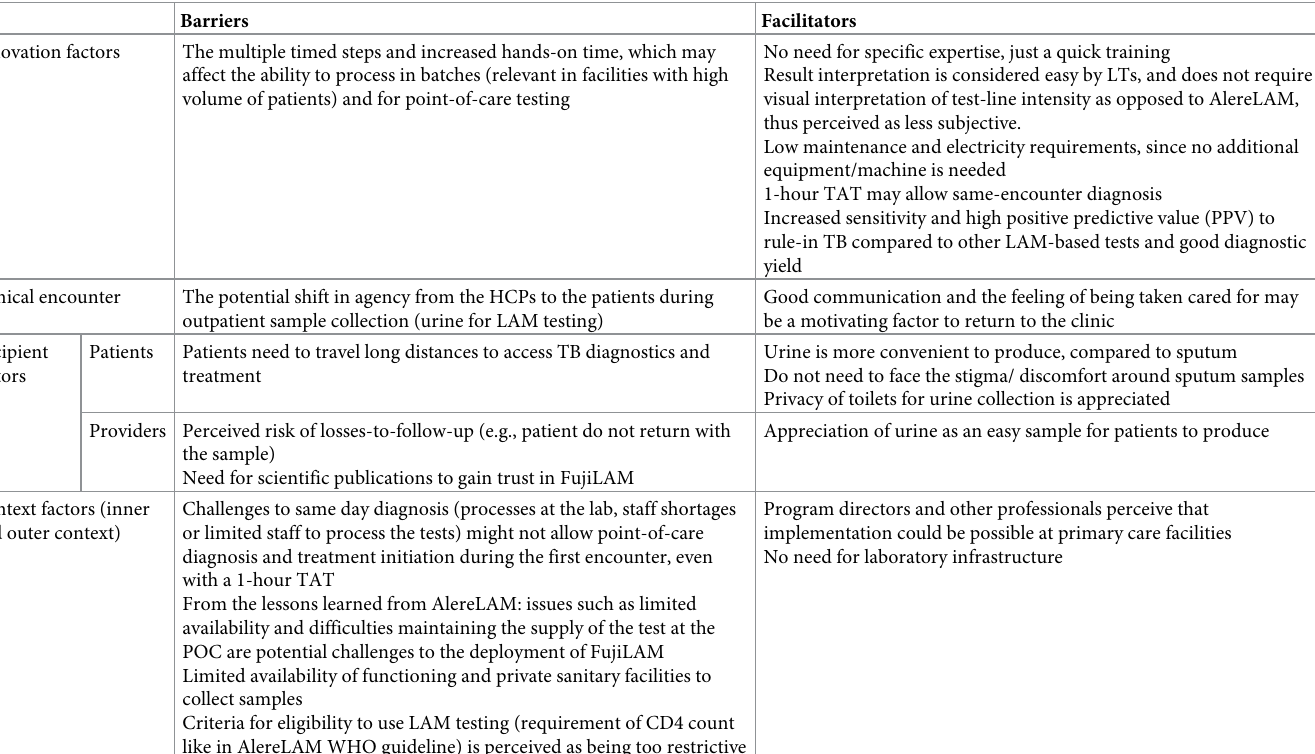
Table 2. Barriers and facilitators to the implementation of FujiLAM, described by innovation factors, patient-provider interaction (or the clinical encounter), recip- ient factors (patient and provider), and the context factors (inner and outer).